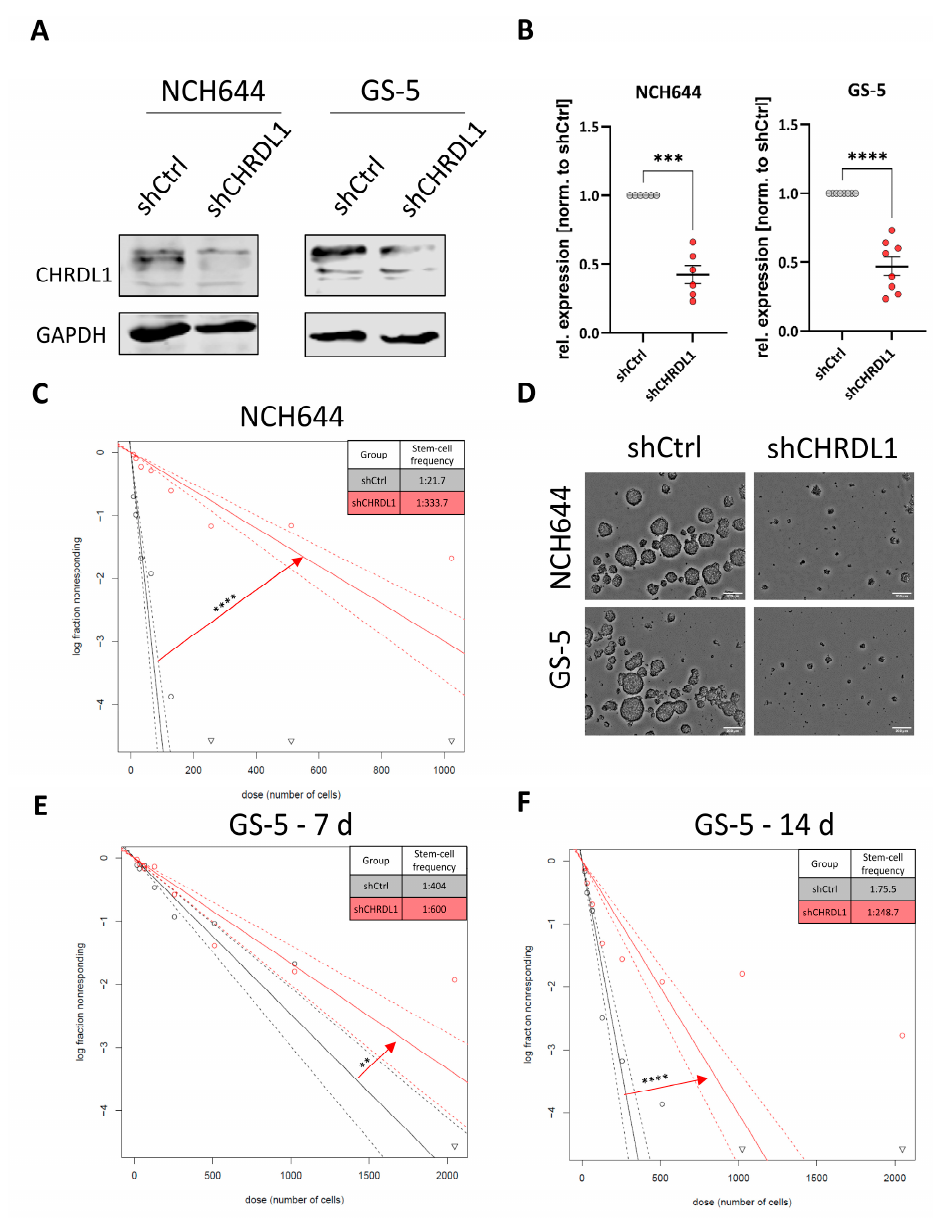
Figure 1. CHRDL1 depletion blocks stemness in GSCs. ( A ) Western Blot of NCH644 and GS-5 GSCs after stable transduction with a non-targeting shRNA (shCtrl) or specific shRNA targeting CHRDL1 (shCHRDL1) and ( B ) Quantification of several independent experiments. ( C , E , F ) Log-fraction plots of the limited dilution model of data from ( C ) NCH644 shCtrl (black) and NCH644 shCHRDL1 (red) GSCs 7 days after seeding the cell in a dilution series from 1024 to 8 cells and analyzing the data using ELDA software [33] . ( D ) Representative microphotographs of NCH644 and GS-5 with and without CRHDL1-depletion. Scale bar: 200 µm. ( E , F ) Data from GS-5 GSCs ( E ) 7 days and ( F ) 14 days after seeding of 2048 to 16 cells. **: p < 0.01, ***: p < 0.001 ****: p < 0.0001. An analysis of the cell cycle after CHRDL1-depletion (Figure 2) revealed that NCH644 (Figure 2A) displayed an increase in cells in the G1-phase with a concomitant decrease in S- and G2/M-phases, indicative of G1-arrest due to CHRDL1-depletion. GS-5 cells display similar cell cycle phase distribution irrespective of CHRDL1 depletion (Fig-